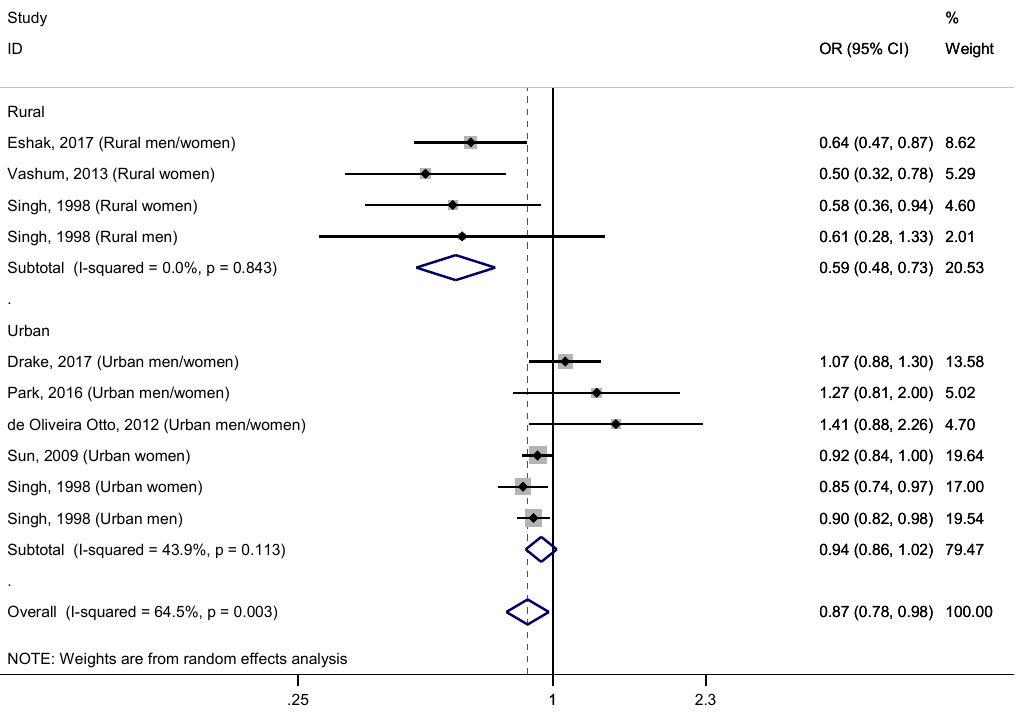
Figure 3. Forest plot of pooled effect size of the highest vs. lowest dietary zinc intake for T2DM according to area of residence (rural vs. urban). Squares represent ORs for each study, and the size of the square is the study-specific statistical weight. Horizontal lines indicate the 95% CI of each study. Diamond represents the combined OR estimate with corresponding 95% CI.